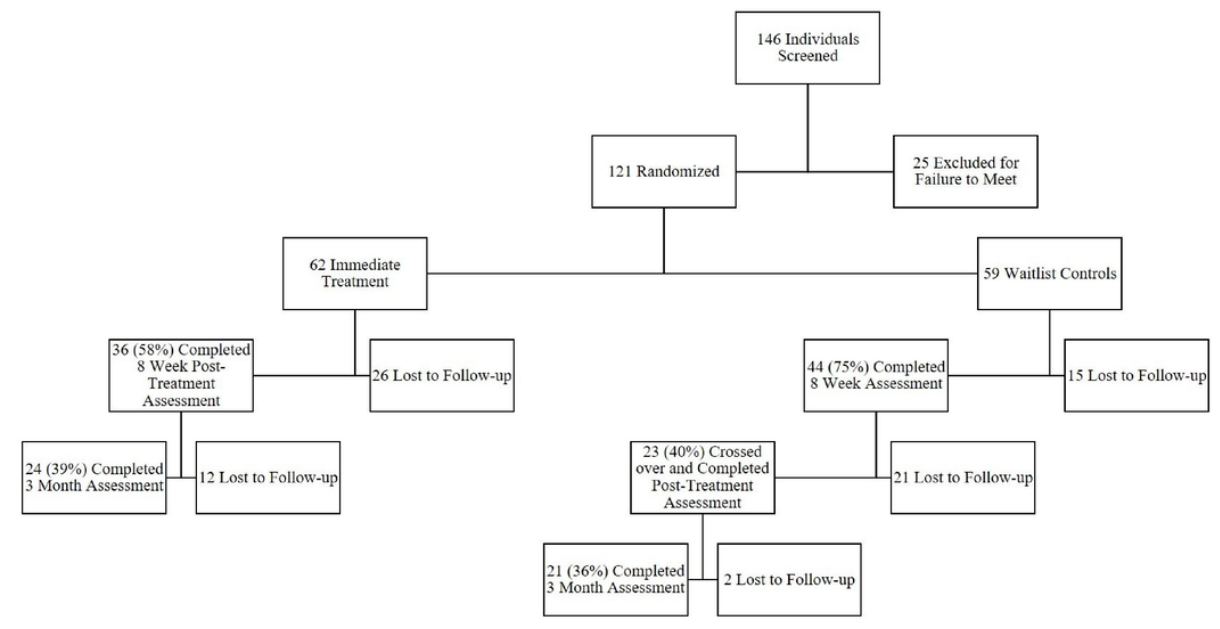
Figure 2. CONSORT diagram of participant flow through the